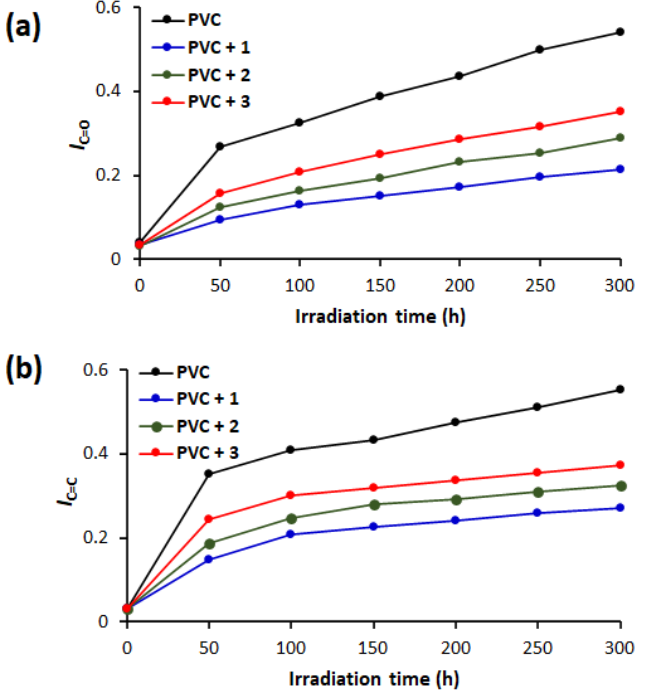
Figure 3. Changes in ( a ) the I C=O and ( b ) the I C=C of PVC films during irradiation.